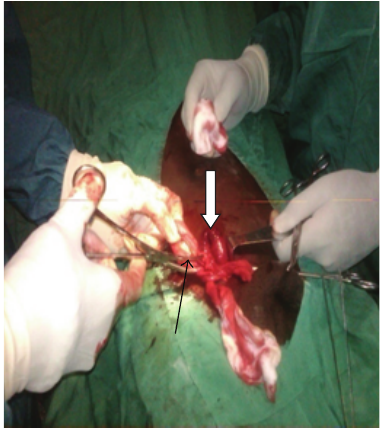
Figure 1: Loop of ileum with ischemia at convex margin ( white arrow ) and adherent inflamed appendix ( black arrow ).